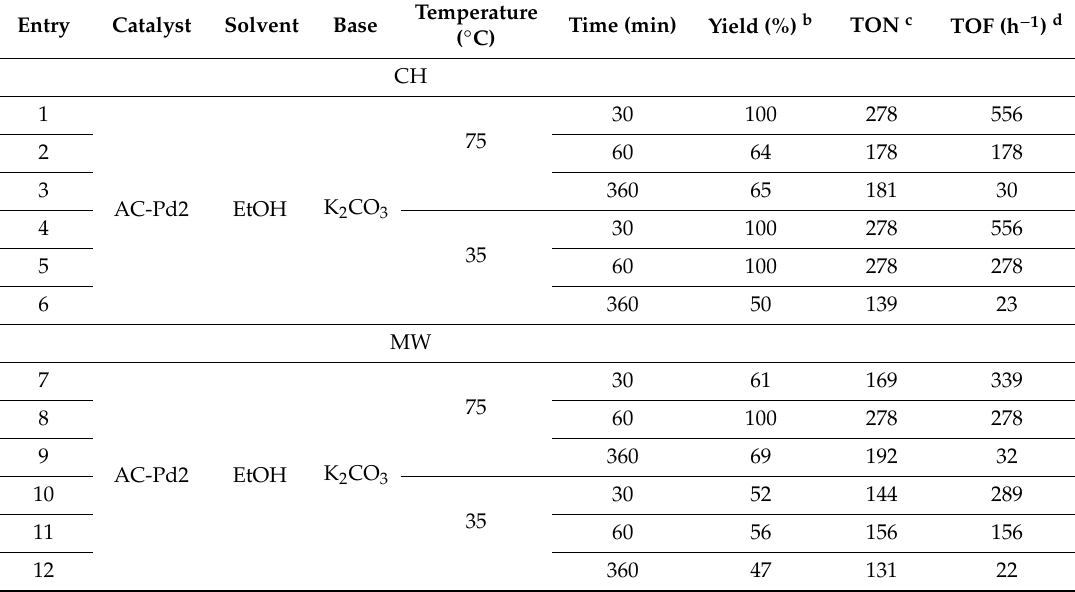
Table 6. E ff ect of the other energy inputs for the solid-state Suzuki-Miyaura cross-coupling reaction of bromobenzene with phenylboronic acid by AC-Pd2 a